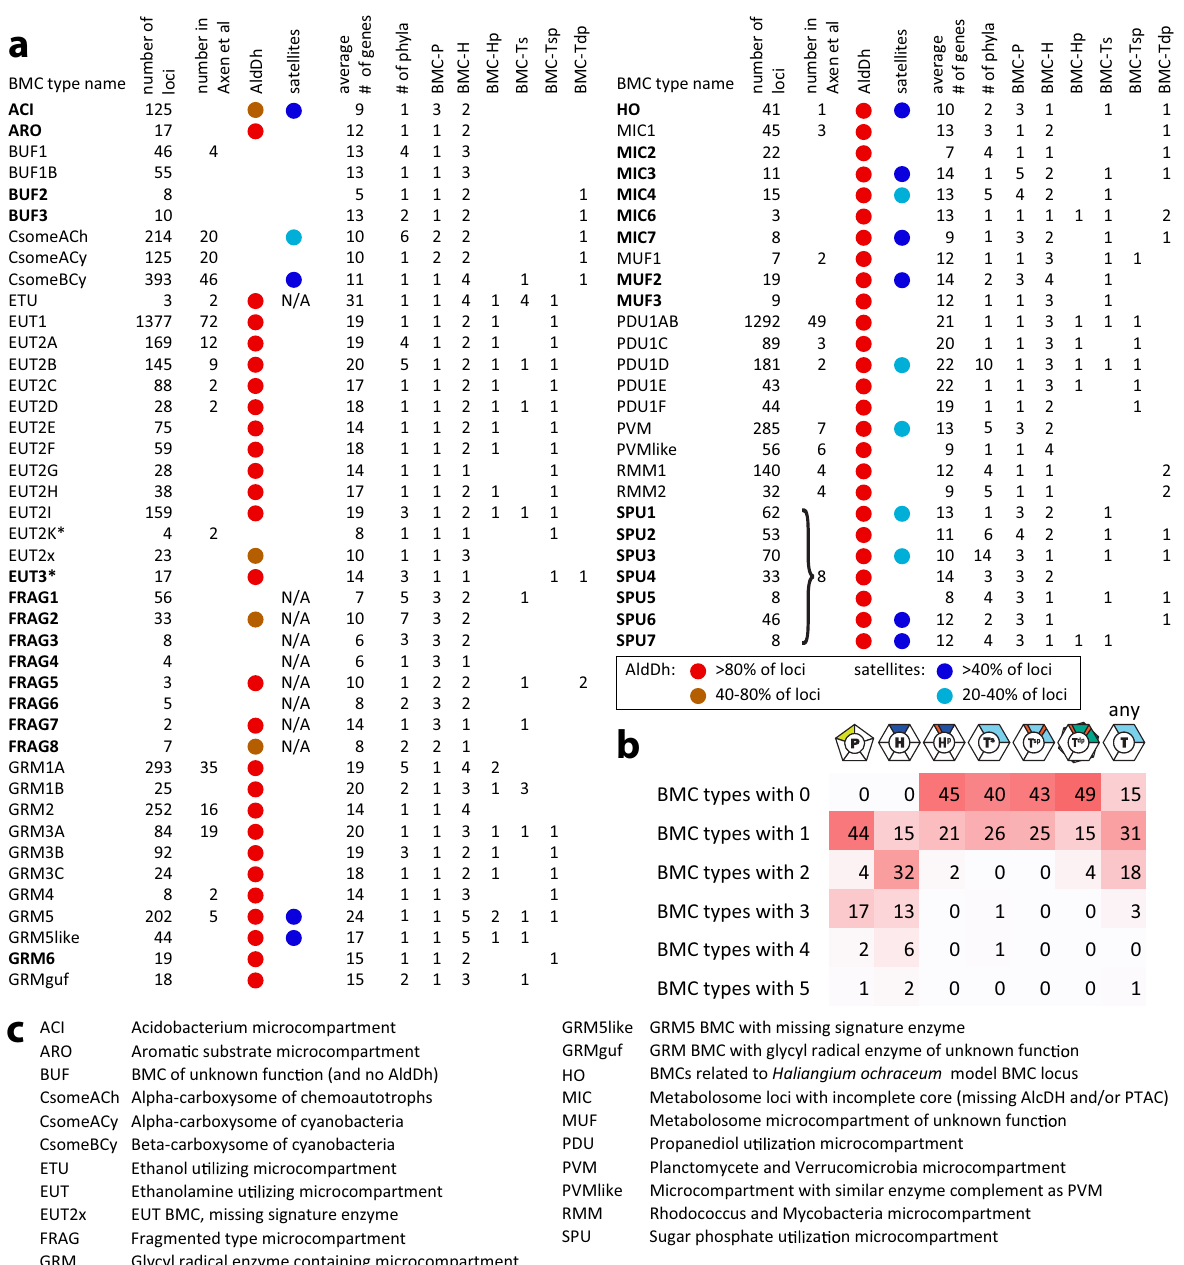
as three paralogs (Fig. 2b). Correlating the BMC-P found in the loci that have three copies with their location on the BMC-P tree (Fig. 3a), we fi nd a “ BMC-P triplet ” pattern: one member each from the gray and orange major clades and a third member from